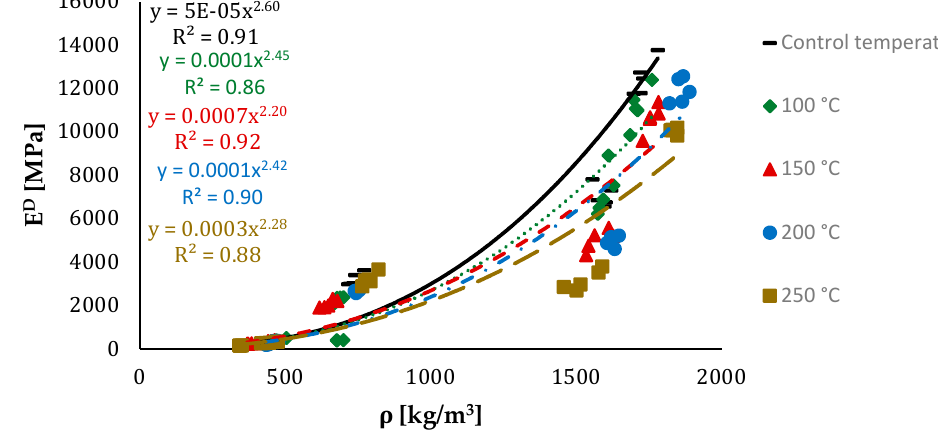
Figure 9. Relationship between bulk density and Young’s modulus.